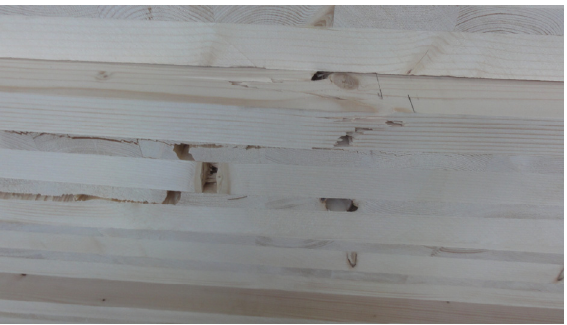
Figure 13. Failure of the 5-layer CLT panel after the experimental testing (detail).